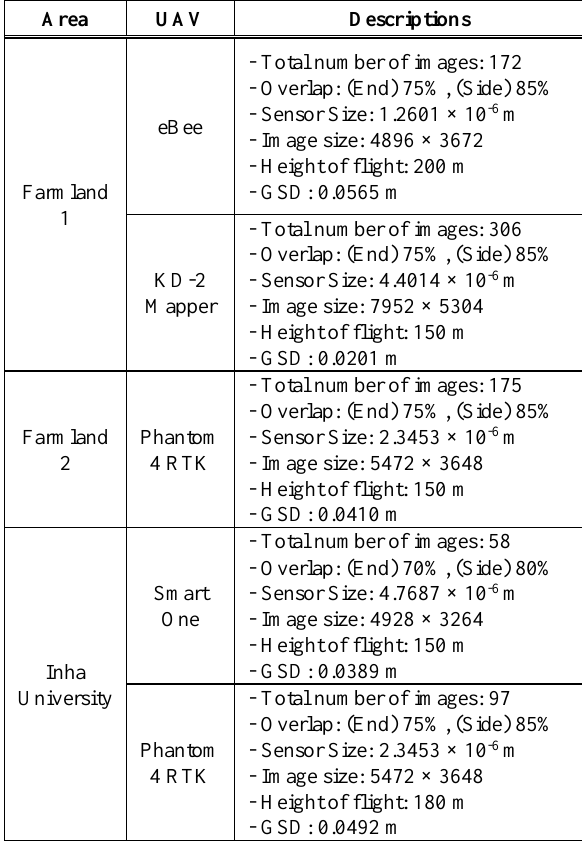
Table 3. Descriptions of the dataset